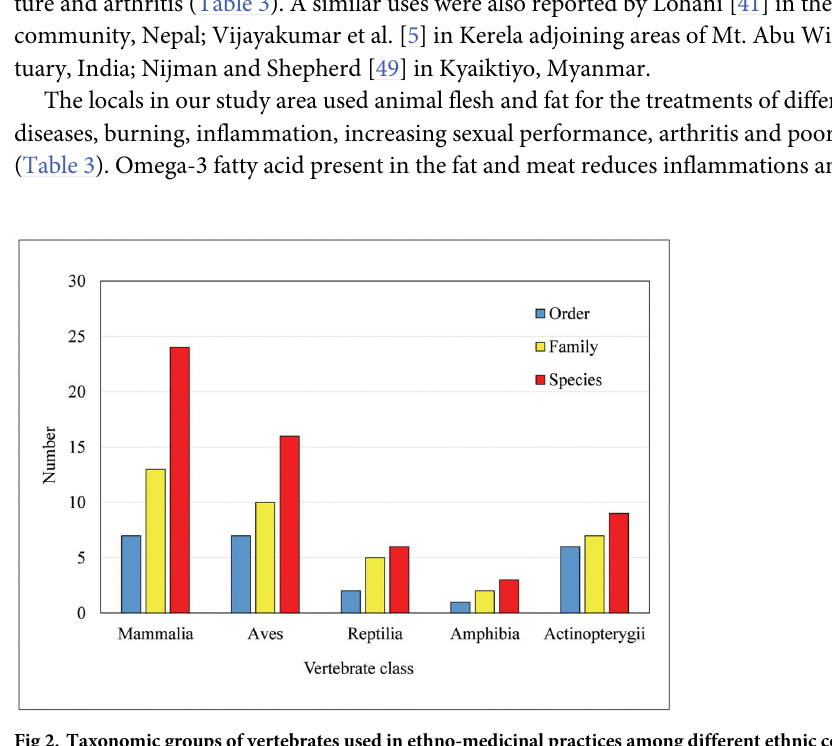
Fig 2. Taxonomic groups of vertebrates used in ethno-medicinal practices among different ethnic communities of the Chitwan-Annapurna Landscape.